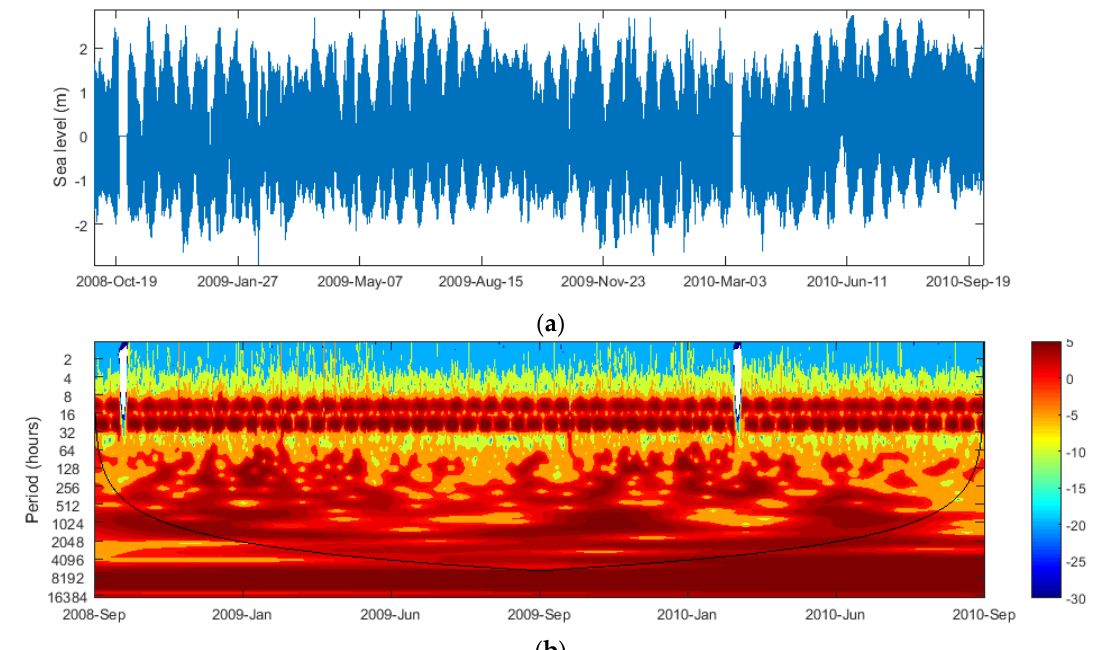
Figure 8. Typical results of wavelet analysis on sea-level records at Bushehr station ( a ) Time series of sea level and ( b ) Wavelet analysis.